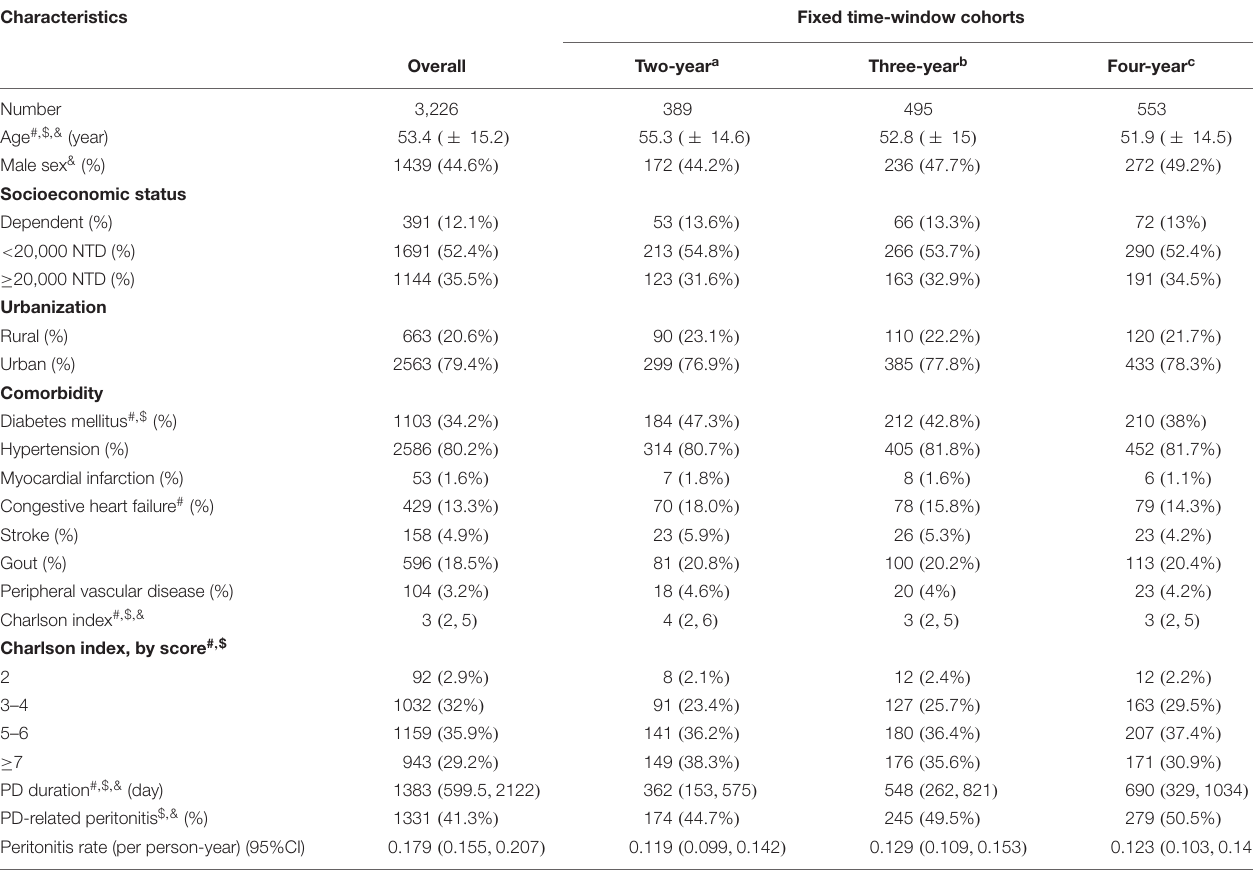
TABLE 1 | Patient characteristics in overall and different fixed time-window